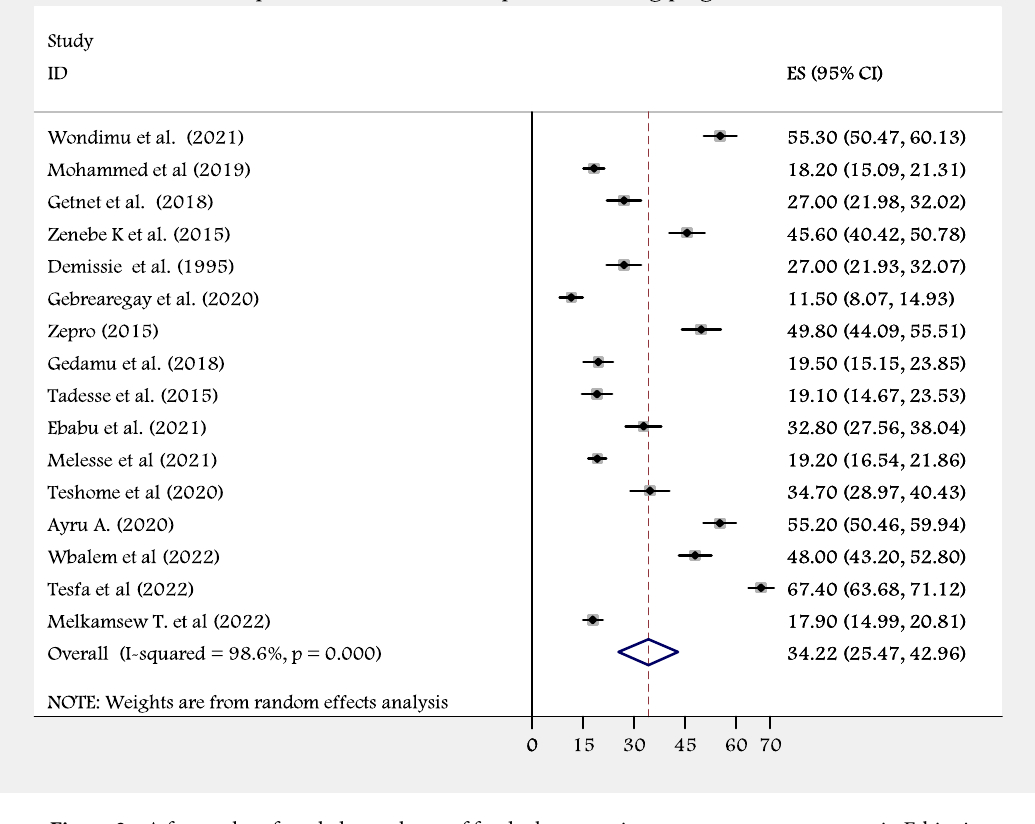
Figure 2. A forest plot of pooled prevalence of food taboo practices among pregnant women in Ethiopia.